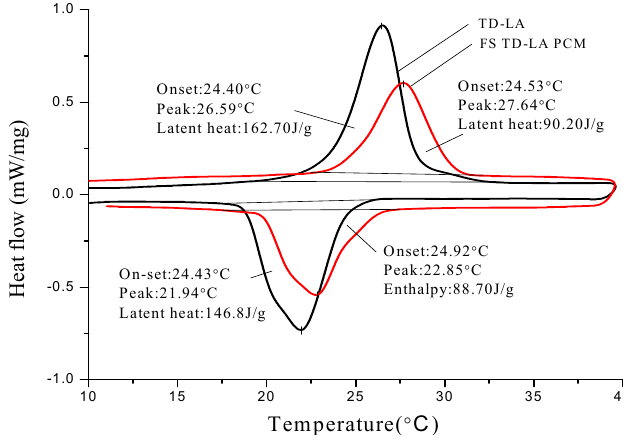
Figure 9. DSC curves of TD-LA eutectic mixture and FS TD-LA PCM. Their onset temperatures, peak temperatures, and latent heat are present.